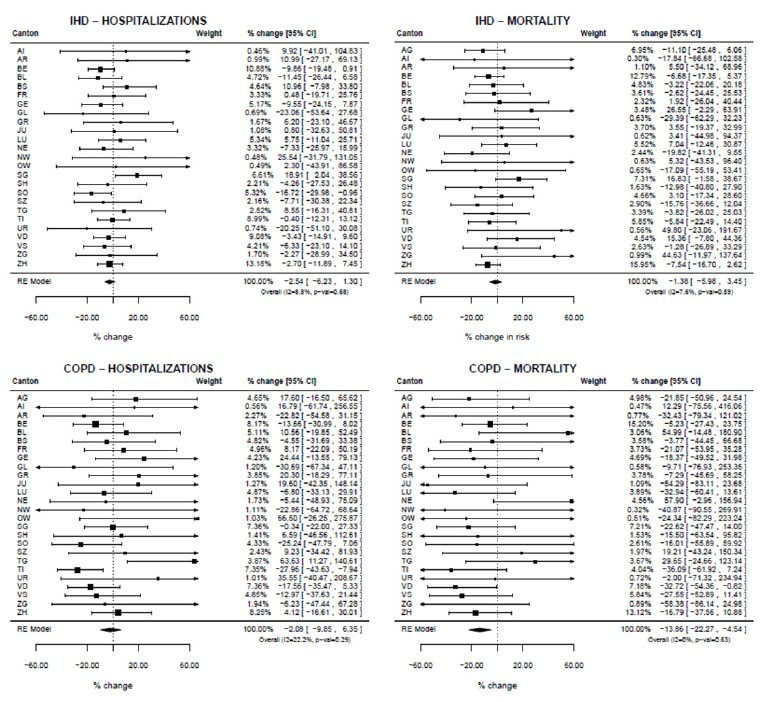
Figure S3 Forest plots of the overall and canton-specific results for ischaemic heart disease (IHD) and chronic obstructive pulmonary disease (COPD) hospitalisations and mortality in adults ≥35 years old after the introduction of the smoking ban. (Canton Argau was excluded from IHD hospital admission